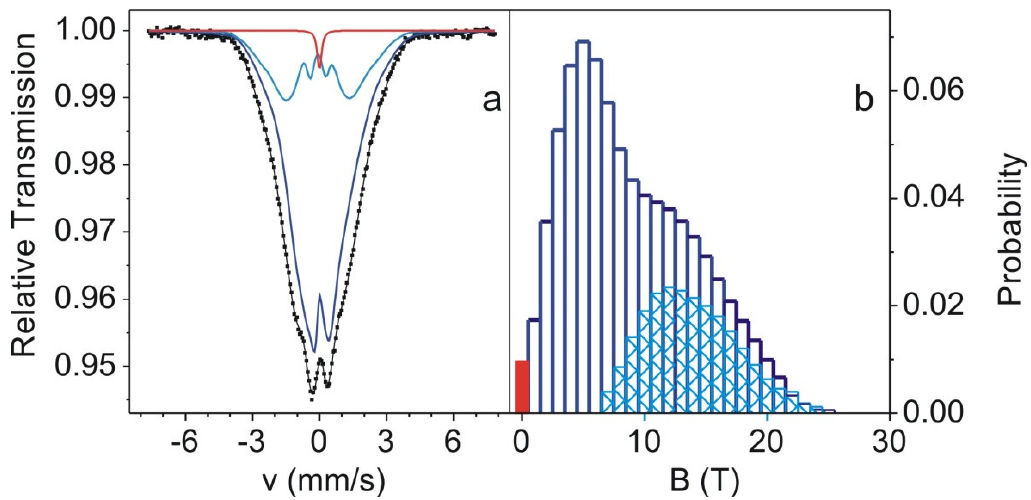
Figure 3. Transmission Mössbauer spectra ( a ) and corresponding hyperfine field distributions ( b ) for the Fe 60 Co 12 Gd 4 Mo 3 B 21 alloy.